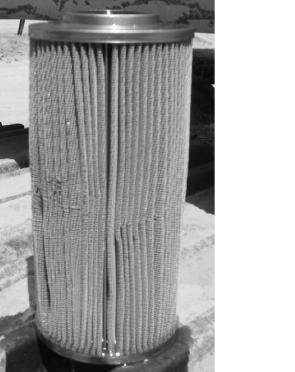
Figure 3 – Filter cartridge embedded in the return line of the hydraulic hammer system Slika 3 – Filterski uložak, ugra đ en u povratnom vodu hidrauli č nog sistema č eki ć a